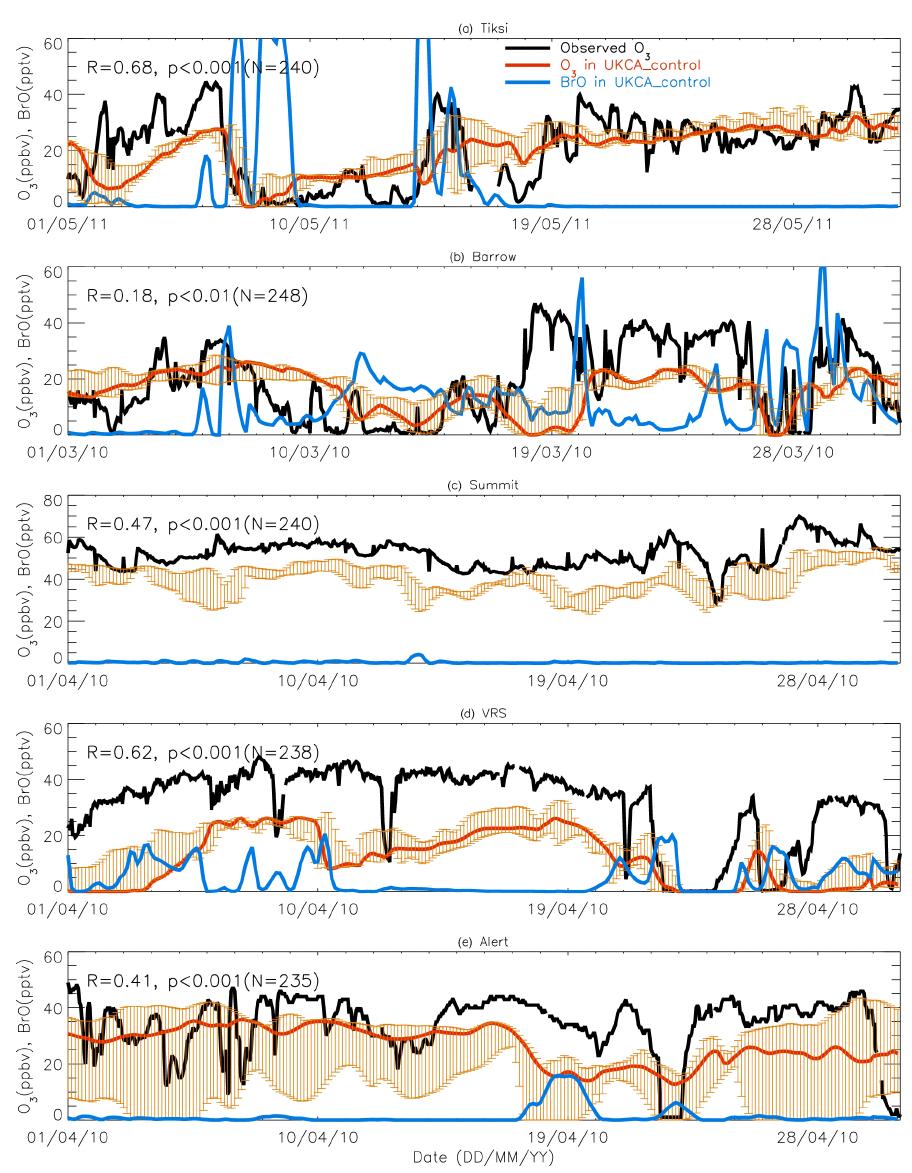
Figure 8. Same as Fig. 7 but for UKCA_control run results.